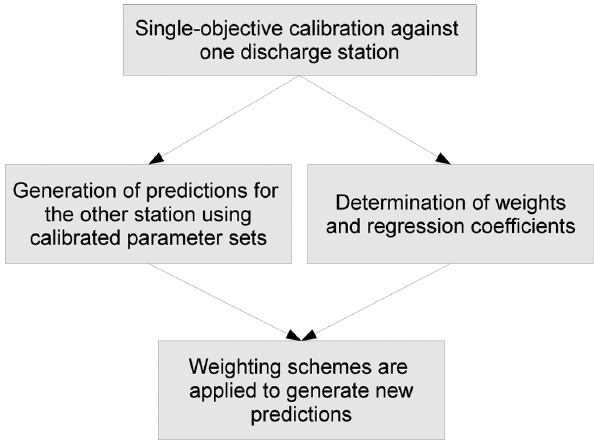
Fig. 2. Ensemble construction